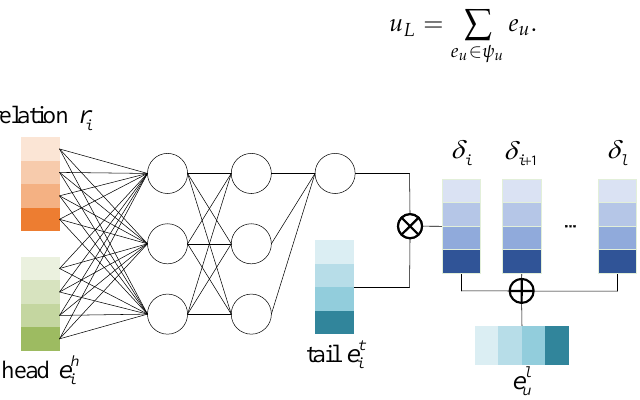
Figure 3. Knowledge-aware attention